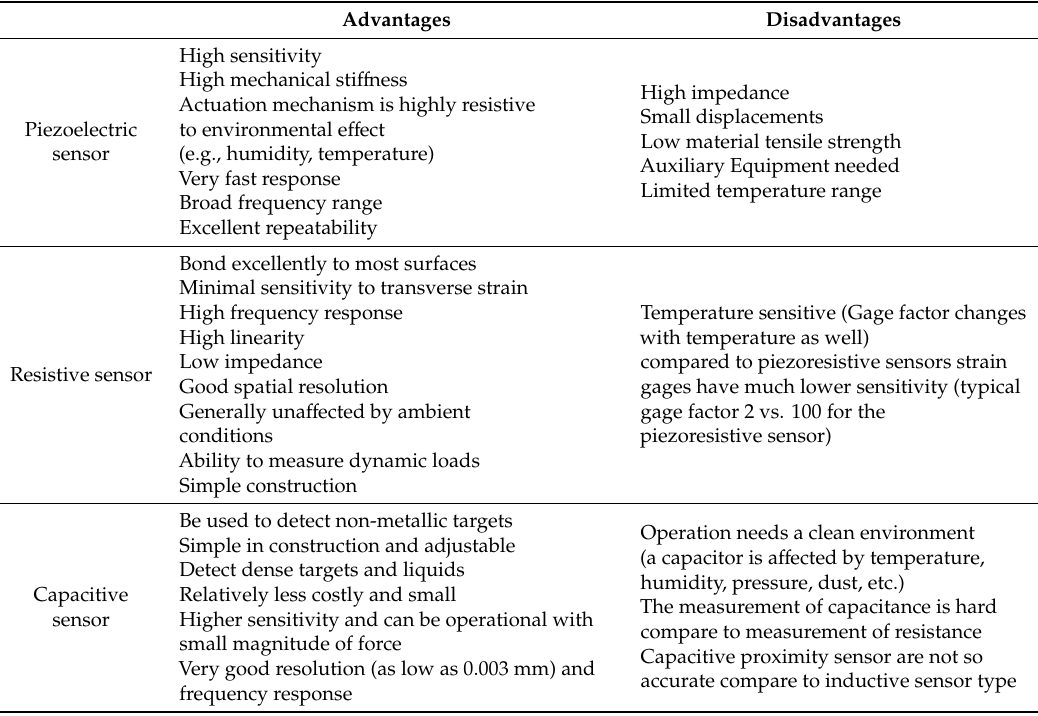
Table 2. Comparison of advantages and disadvantages of piezoelectric, resistive and capacitive